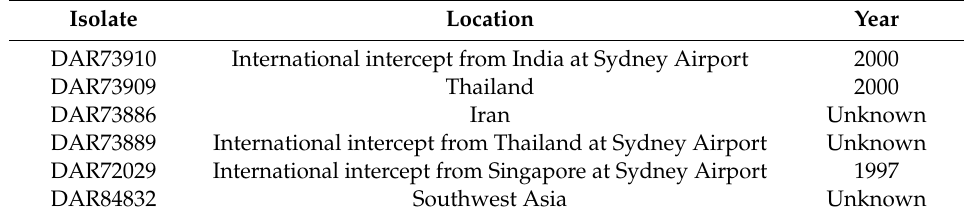
Table 1. Isolates genome sequenced in this